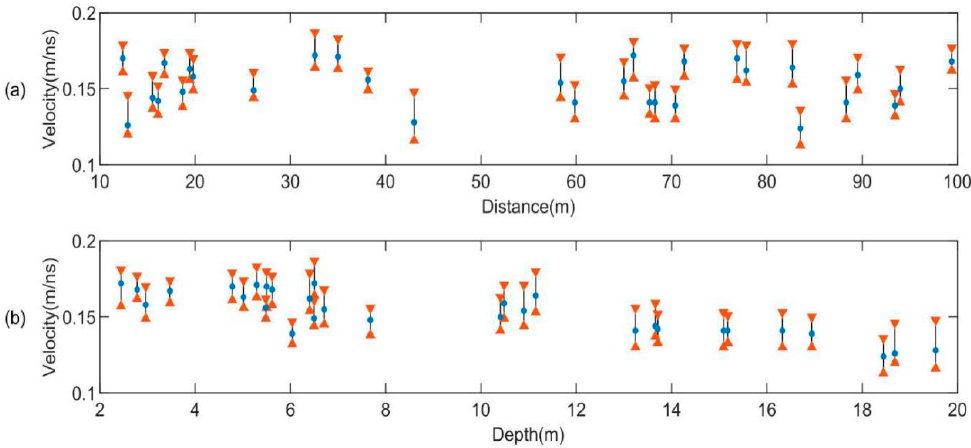
Figure 16. Distributions of velocities and error ranges. ( a ) Velocities and error ranges with distance. ( b ) Velocities and error ranges with depth. The triangular points represent the error ranges; the blue dots represent the estimated velocities.